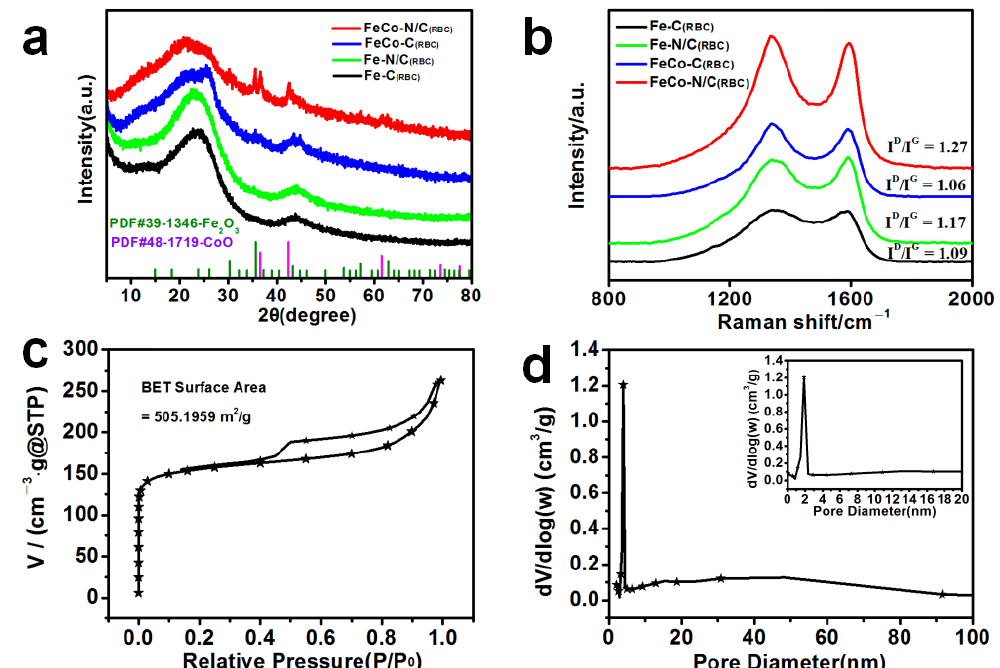
Figure 3. ( a ) XRD patterns of Fe-C (RBC) , Fe-N/C (RBC) , FeCo-C (RBC) and FeCo-N/C (RBC) . ( b ) Raman spectra of Fe-C (RBC) , Fe-N/C (RBC) , FeCo-C (RBC) and FeCo-N/C (RBC) . ( c ) N 2 adsorption-desorption isotherms of FeCo-N/C (RBC) . ( d ) Pore-size distributions of FeCo-N/C (RBC), top right corner is the enlarged view of the graph.